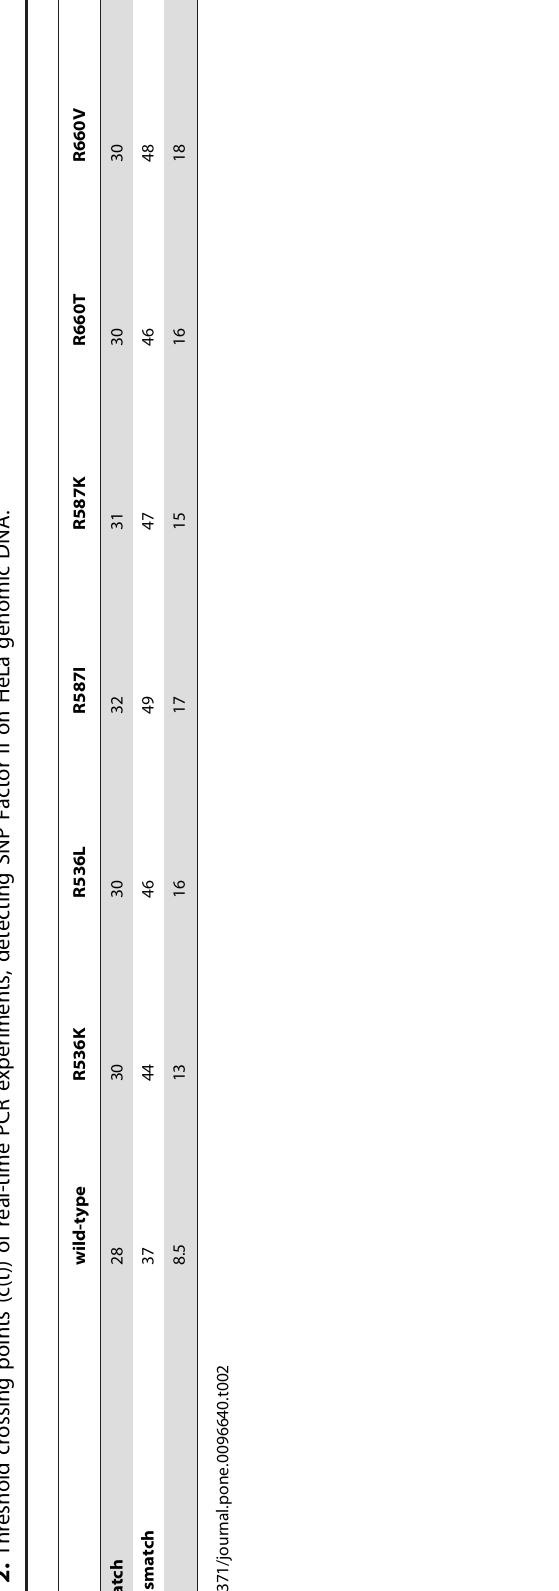
Figure 5. Multiplexing ASA melting curve assay of Factor II prothrombin. A) Melting curves of the multiplexing ASA products resulting from three different reference gDNA samples are shown (wild- type in blue (genotype G/G), heterozygote in black (genotype G/A), homozygote in red (genotype A/A)). B) Resulting melting curve from a whole blood sample, identifying the wild-type genotype.